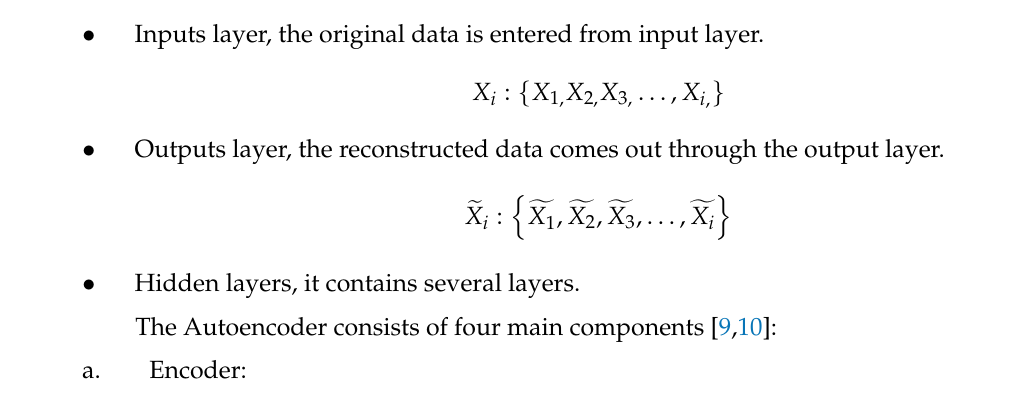
Figure 1. Autoencoder Architecture.